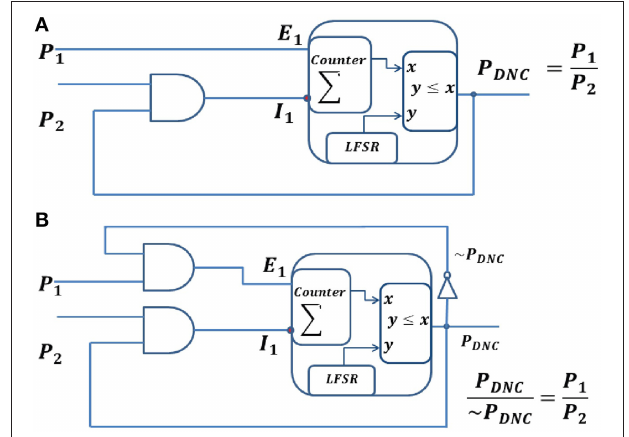
FIGURE 5 | Division neural circuits for spike train inputs, P 1 and P 2 . (A) Division neural circuit for P 1 ≤ P 2 (B) Division neural circuit to represent the division of P 1 and P 2 expressed as the ratio of the two output lines. It can be used irrespective of whether P 1 is less than, equal to or greater than P 2 .